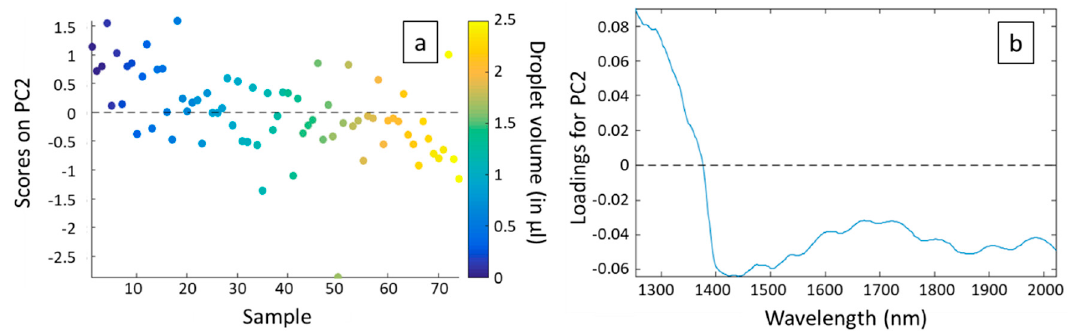
Figure 6. Scores ( a ) and loadings ( b ) related to PC2. Note that in (a) the samples are classified by increasing volume, regardless of the origin of the series (S1, S2, or S3).